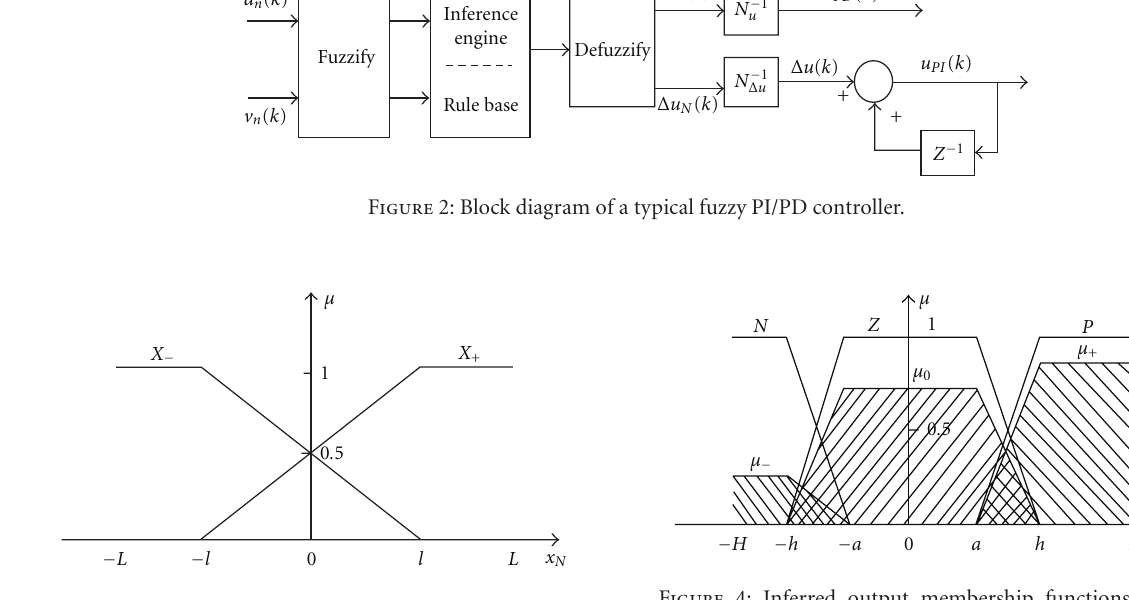
Figure 3: Input membership functions.